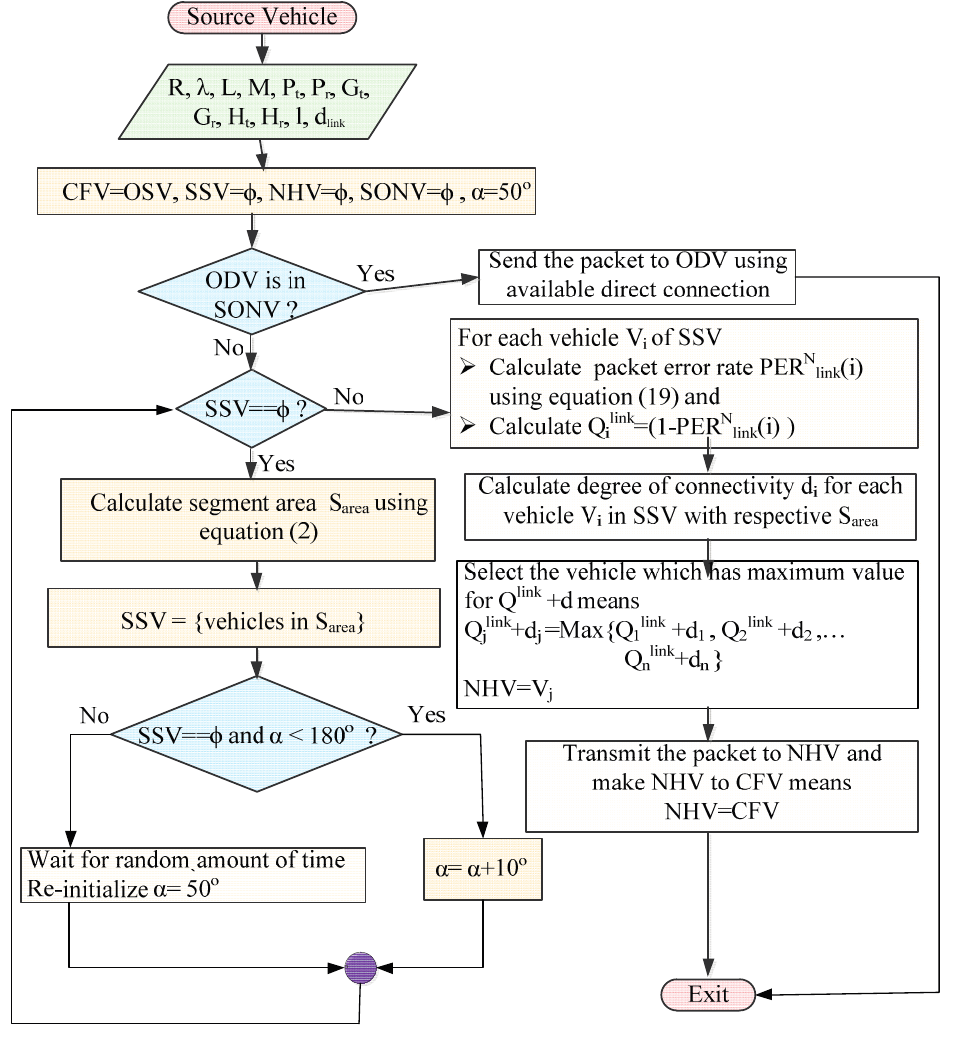
Figure 7. Flowchart of the SLD-GEDIR